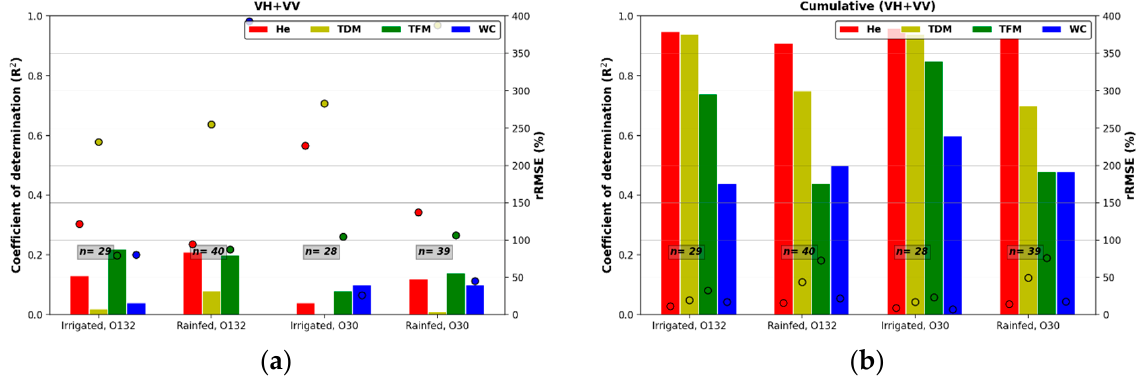
Figure 9. Impact of irrigation practices evaluated by the coefficient of determination and the relative error (rRMSE), calculated for the ( a ) VH + VV and ( b ) cumulative (VH + VV) index, as a function of the He (red bars), TDM (yellow bars), TFM (green bars) and WC (blue bars).